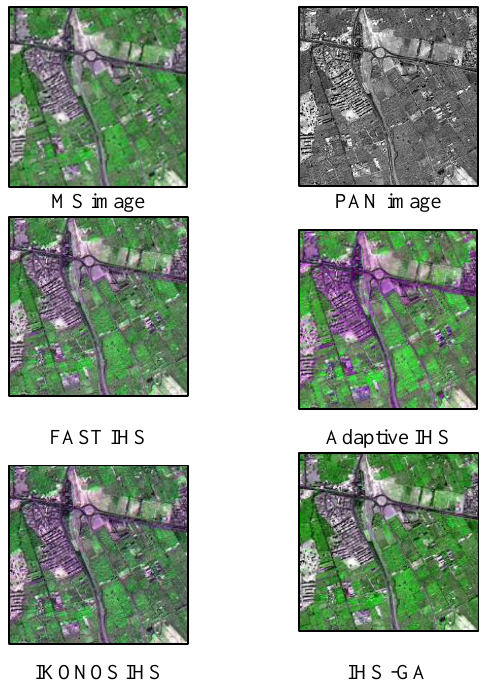
Figure 3. outputs of methods(IKONOS data sat)